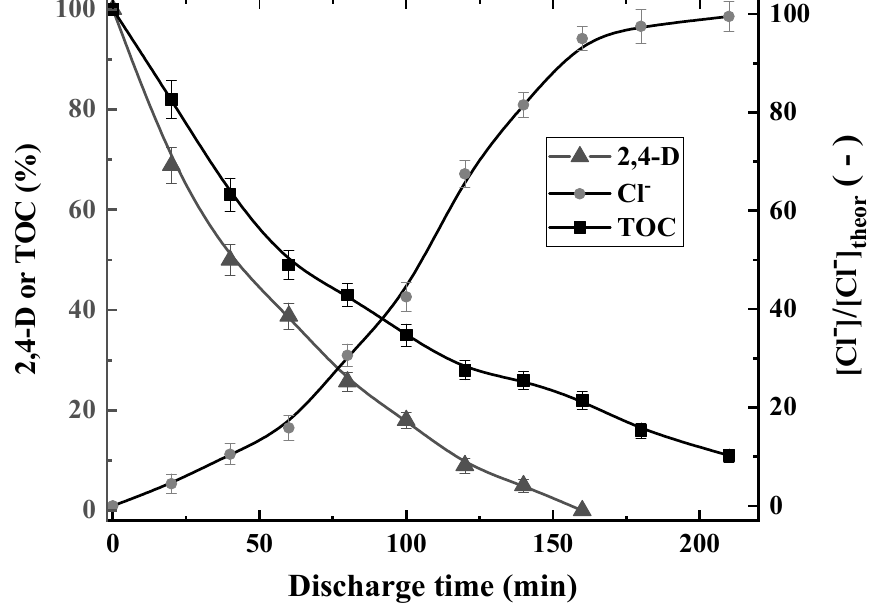
Figure 2. Decays of 2,4-D and TOC and formation of Cl − during RFD treatment. ([2,4-D] 0 , 1.0 mM; input power, 200 W; pH 0 , 6.51).